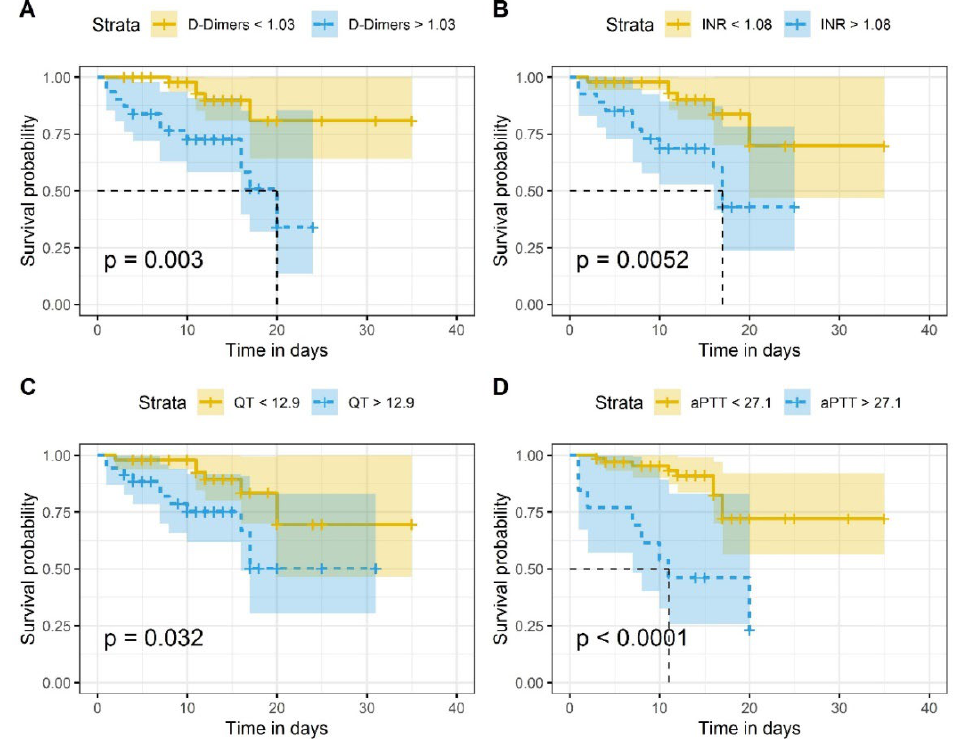
Figure 3. Kaplan–Meier survival curves of COVID-19 in-patients: ( A ) in accordance with established D-Dimer cutoff values (1.03 µ g/mL); ( B ) in accordance with established INR cutoff values (1.06); ( C ) in accordance to established PT cutoff values (12.9 s); ( D ) in accordance with established aPTT cutoff values (27.1 s). On the x-axis is represented the time in days and on the y-axis the survival probability. The p -values show that the survival distributions are statistically significantly different. The null hypothesis tested is that there is no difference in the distribution of overall survival between groups (with coagulation biomarker levels above or below cut-off values) in the study population.